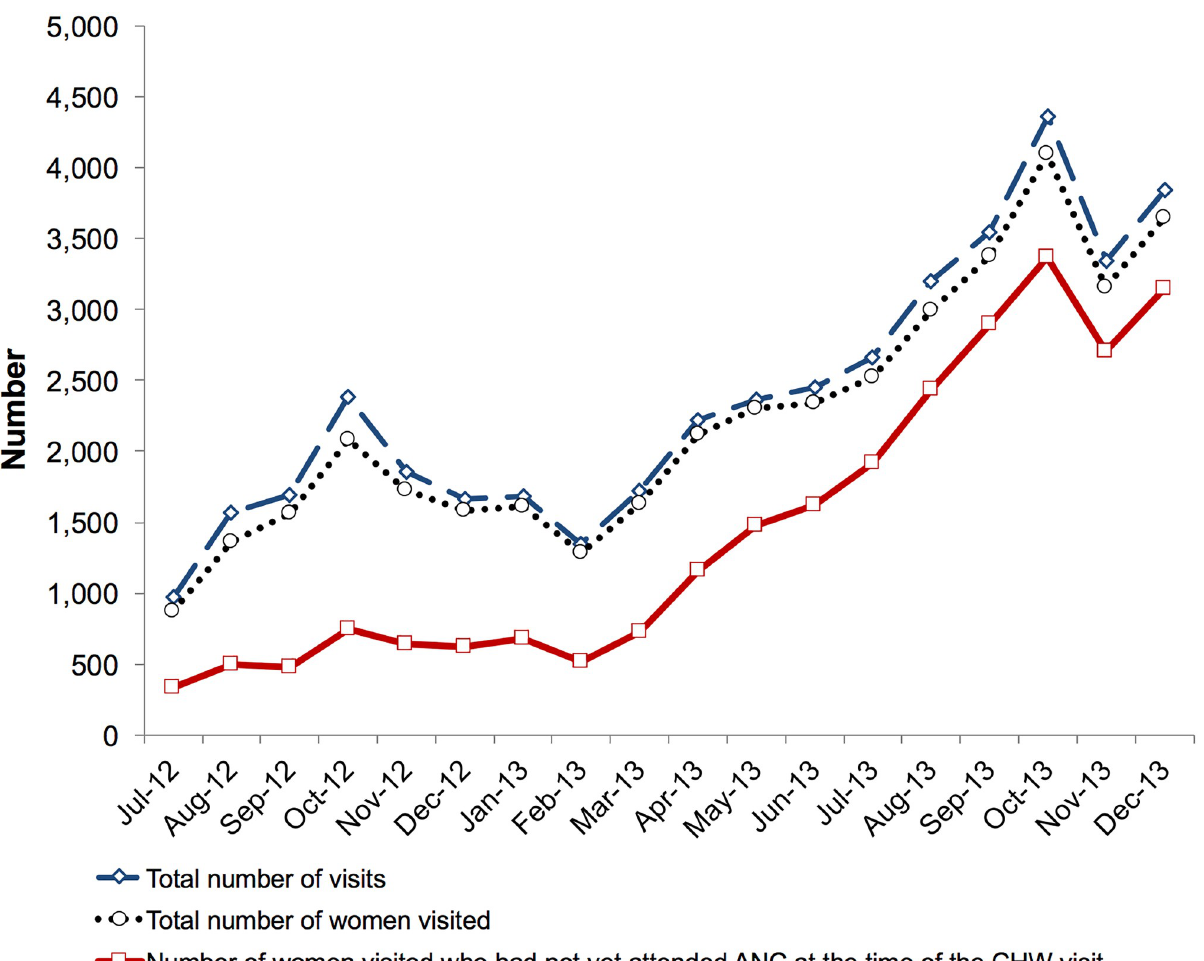
Fig 2. Home visits by CHWs over the study period, by month. These data were obtained from clinical registers that the CHWs in the intervention wards filled out and submitted to their supervising community outreach nurses at the healthcare facilities. The difference between the total number of visits and total number of women visited arose from the fact that some women were visited more than once during a given month. ANC, antenatal care; CHW, community health